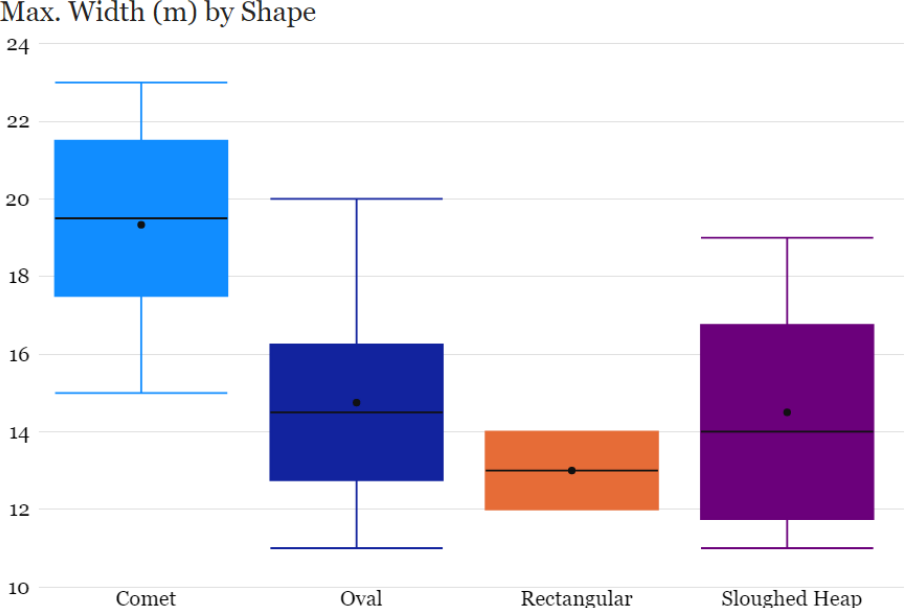
Figure 6. Box Charts of Max. Width (m) by Dump Profile Shape.